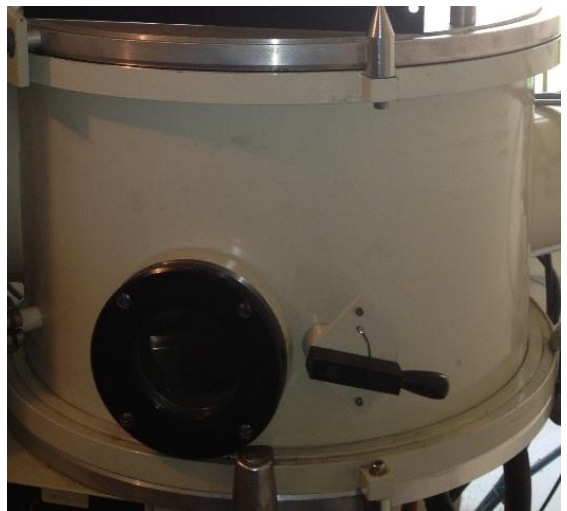
Figure 2. Deposition